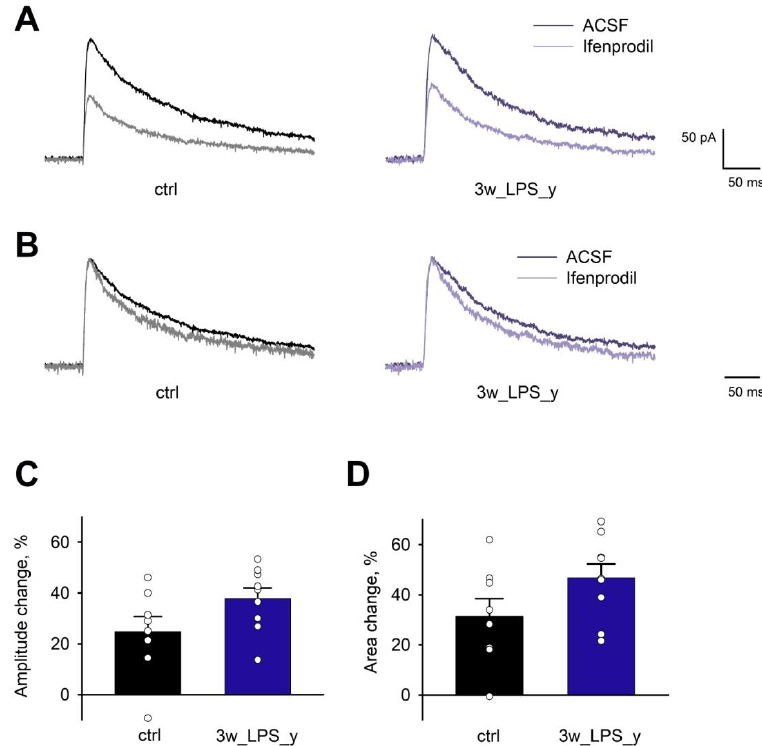
Figure 5. The effect of ifenprodil on eEPSCs in CA1 pyramidal neurons. ( A ) Representative examples of evoked NMDAR-mediated EPSCs recorded at +40 mV in the presence of bicuculline (10 μM), picrotoxin (50 μM), and CNQX (20 μM) in the control and 3wLPS_y groups. ( B ) The same traces as in (A) normalized by amplitude. Note that ifenprodil decreases tau decay. ( C , D ) The effect of ifenprodil on amplitude and area under the curve of NMDAR-mediated eEPSC. Dot points represent data from individual cells. Error bars indicate SE.